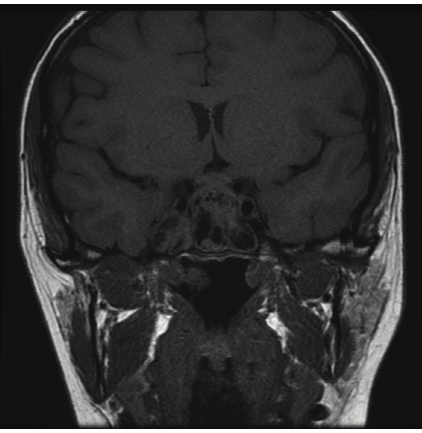
Figure 1: Coronal MRI image showing expanded sphenoid sinus with a suspected mucocele.